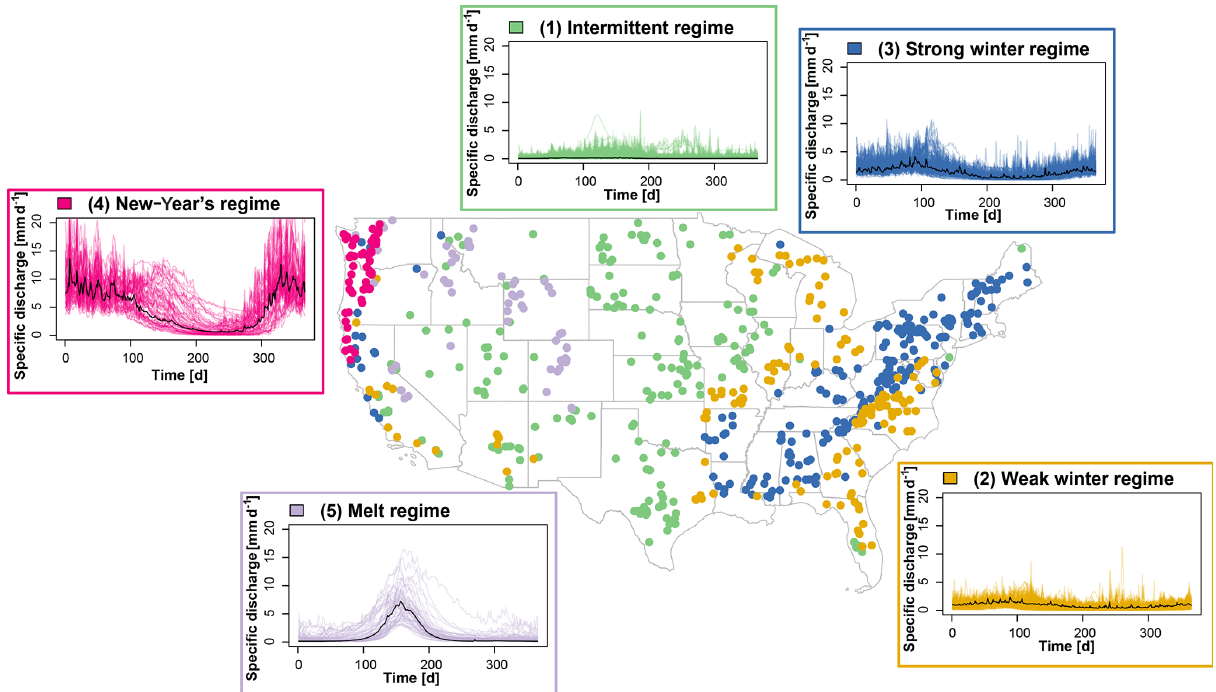
Figure 2. Map of regime clusters and the regimes of the catchments belonging to the five clusters: (1) intermittent regime, (2) weak winter regime, (3) strong winter regime, (4) New Year’s regime, and (5) melt regime. Regimes of individual catchments are colored according to their cluster membership, and the median hydrograph per cluster is given in